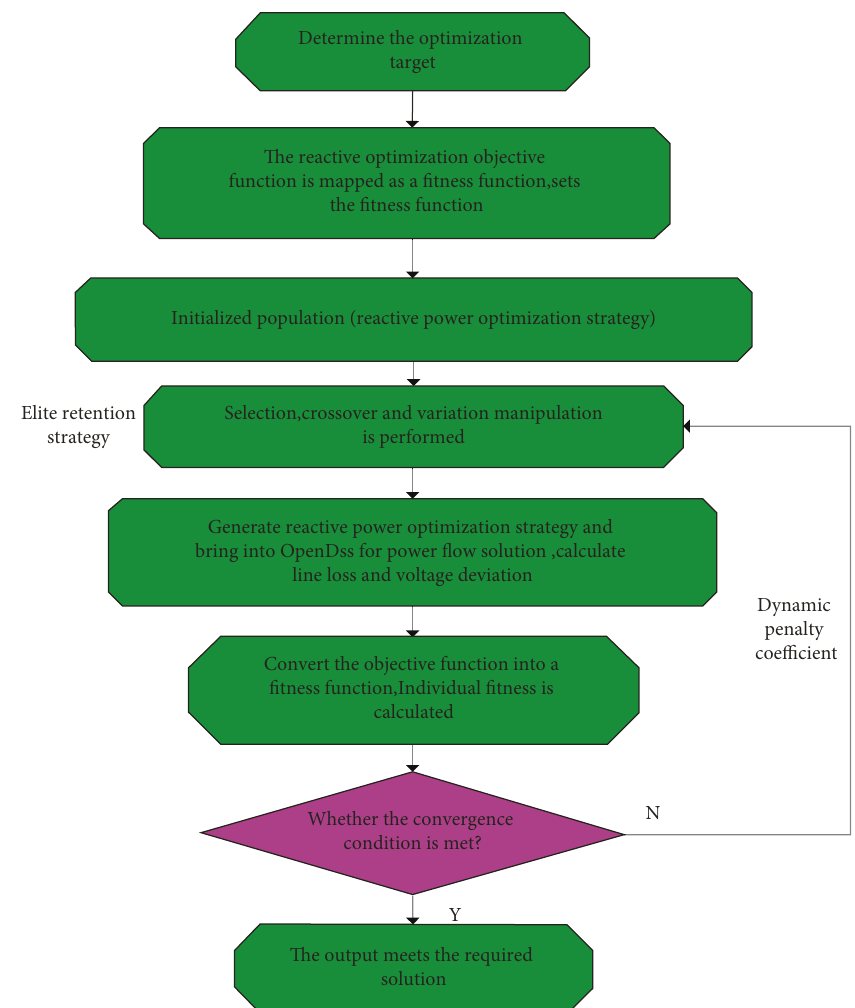
Figure 7: The reactive power optimization process of the distribution network is based on improved GA.